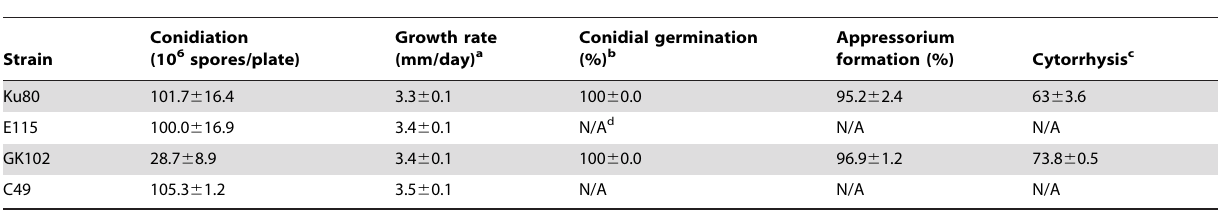
a The growth rate was measured with 14-day-old CM cultures grown in race tubes. Mean and standard deviation were calculated with results from three replicates. b Percentage of conidia germination and appressorium formation by 24 h. Means and standard errors were calculated from three independent repeats (at least 100 conidia were counted in each repeat). c Percentage of appressoria that underwent cytorrhysis in 35% PEG. Mean and standard deviations were calculated from four replicates. At least 100 appressoria were examined in each repetition. d Not assayed.